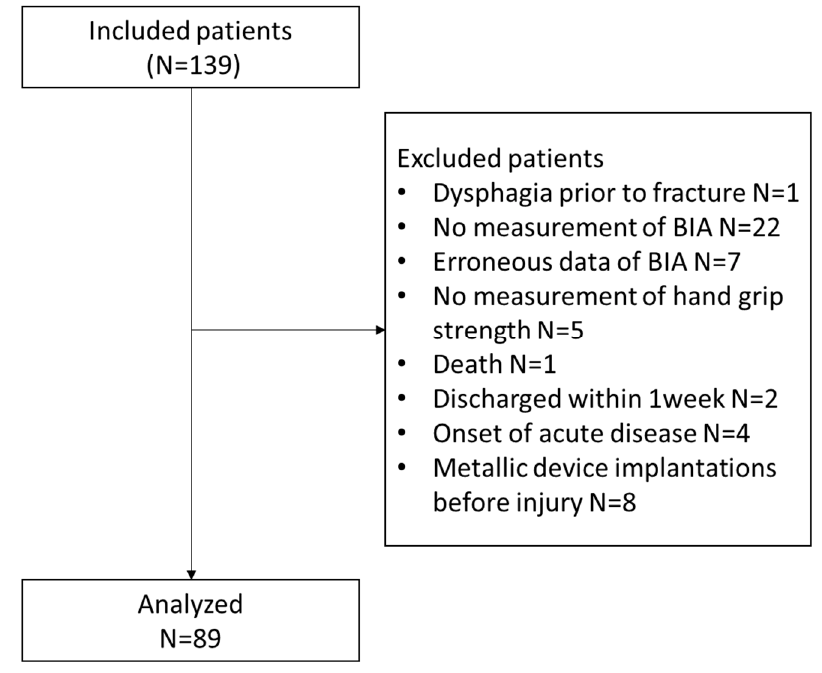
Figure 1. Flow chart for the final study cohort. Table 2. Incidence of dysphagia in di ff erent groups based on SMI.